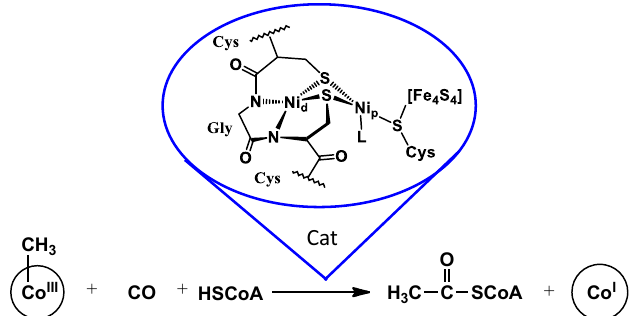
Figure 1. Structure and function of the dinickel enzyme active site of acetyl co-A synthase [3].